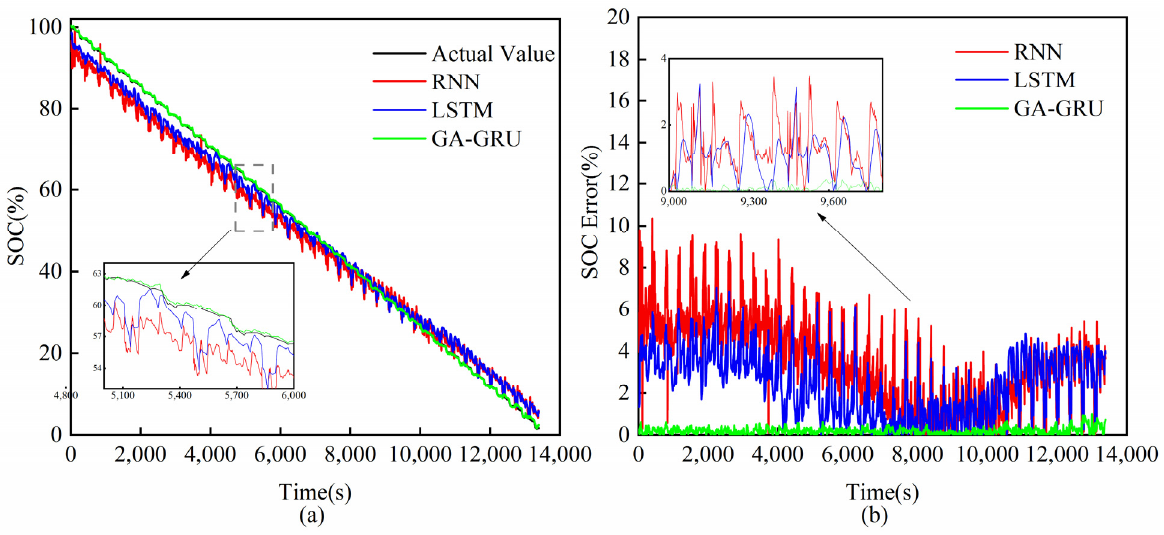
Figure 6. SOC estimation results and errors under DST at 0 °C. ( a ) Comparison of SOC estimation results under DST at 0 °C; ( b ) comparison of SOC estimation errors under DST at 0 °C.